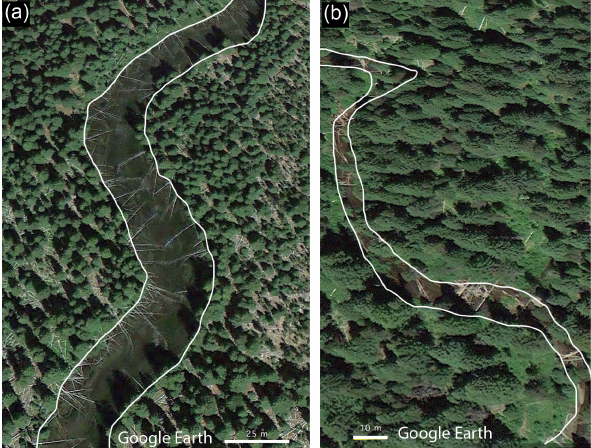
Figure 3. © Google Earth Pro high-resolution imagery showing (a) Cultus River ( q 95 = 2 . 8m 3 s − 1 ) and (b) Cultus Creek ( q 95 = 2 . 3m 3 s − 1 ). Stream channels are outlined in white, and flow direc- tion is down from the top of the image in both panels. These images are representative of the general wood dynamics in the two streams, where most of the wood in panel (a) is single logs, and most of the wood in panel (b) is in logjams, so little of the wood in panel (b) would contribute to the histogram shown in Fig.